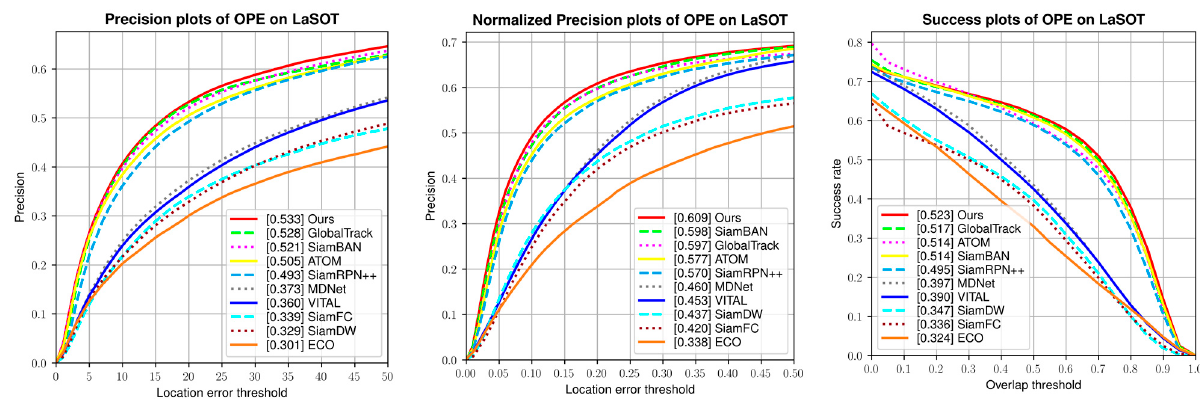
Figure 11. Comparison with other trackers on LaSOT test set in terms of the precision, normalized precision, and success plots.